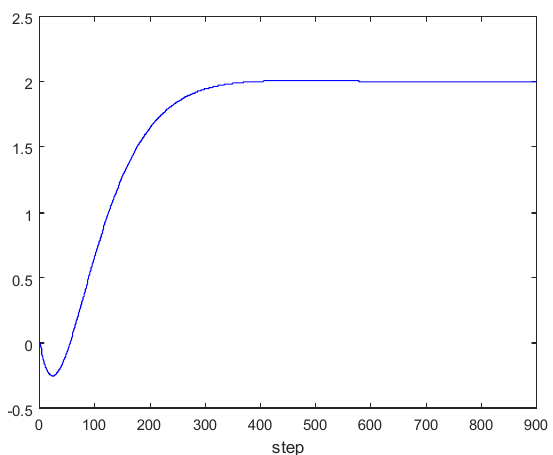
Figure 3. Step response of the 6th order model after reduction to a common denominator simulated for 900 time-steps.